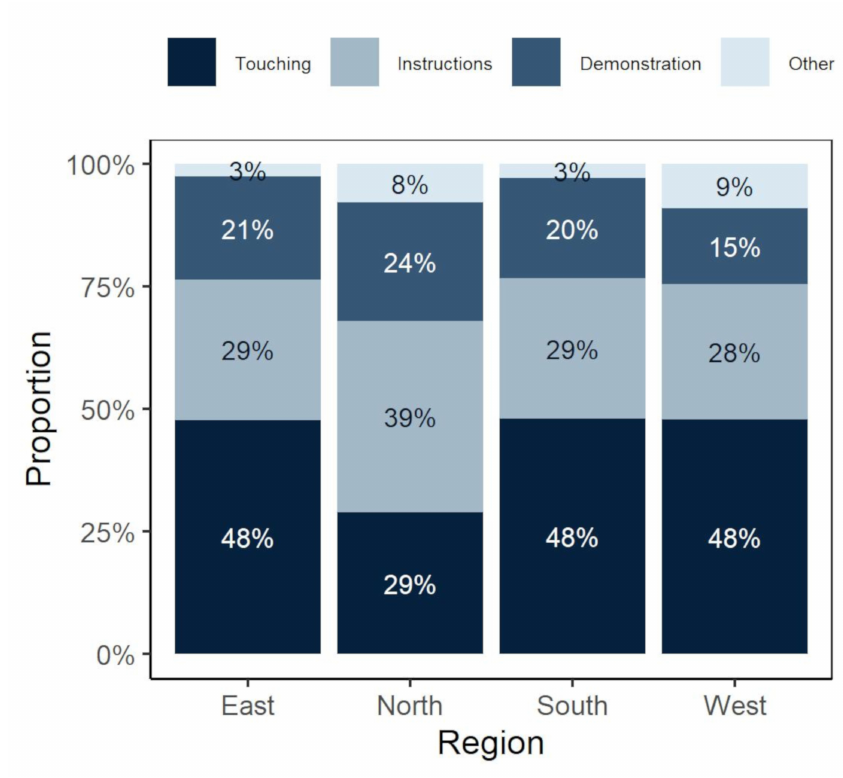
Figure 4. Therapy session composition by